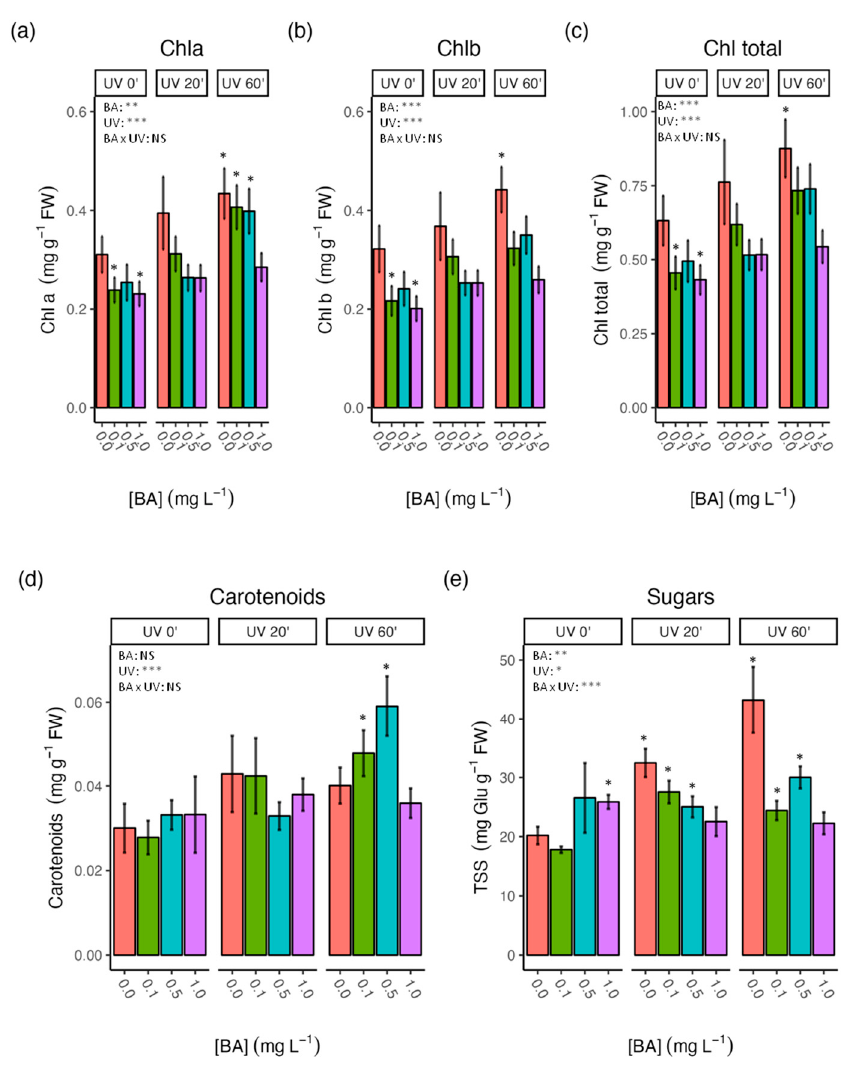
Figure 1. Effect of different concentrations of BA and UV-C treatments on the content of photo- synthetic pigments and sugars in 6-week-old carob shoots. ( a ) chl a ; ( b ) chl b ; ( c ) total chlorophyll; ( d ) total carotenoids; ( e ) total soluble sugar (TSS) contents. Each value represents the mean ± SE. Significant differences from the untreated controls by Tukey’s HSD test at p ≤ 0.05 are indicated with asterisks over the bars. p -values of the two-way ANOVA for the effects of benzyl adenine dose (BA), UV-C treatment (UV) and their interaction (BA × UV) are indicated by asterisks: *, p ≤ 0.05; **, p ≤ 0.01; ***, p ≤ 0.001; NS, not significant.